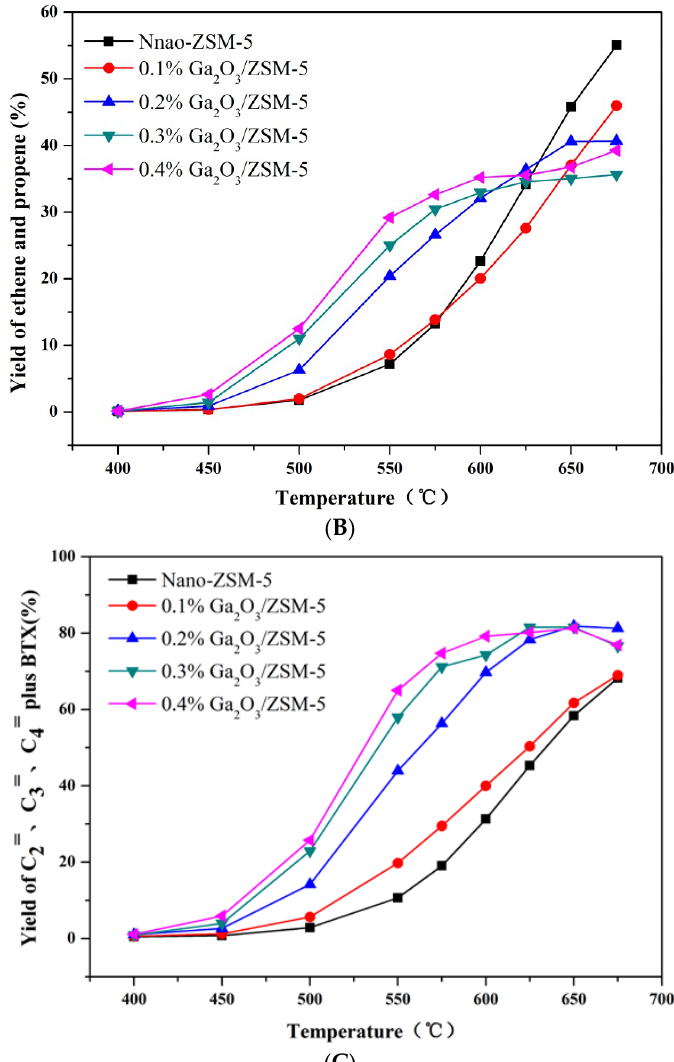
Figure 7. The conversion of n -butane ( A ); the yield of ethane and propene ( B ) and C 2= , C 3= , C 4= plus BTX ( C ) of the catalysts with different Ga 2 O 3 loadings as a function of reaction